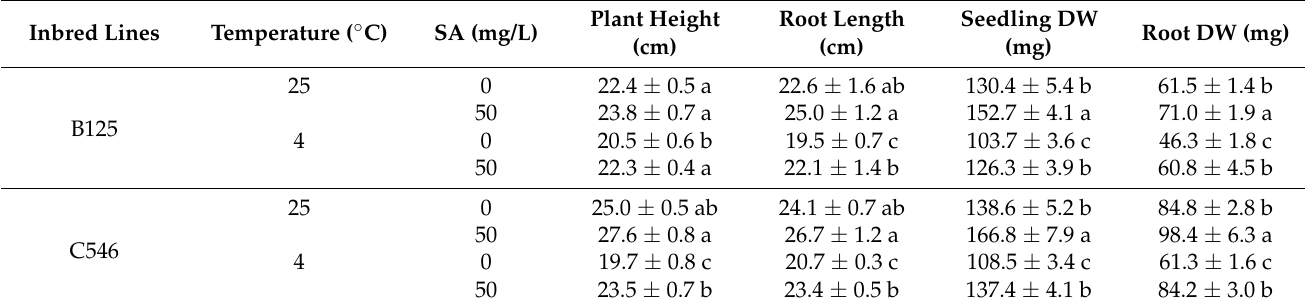
DW—dry weight. The values show the mean ± SE. The values marked with different letters indicate significant differences between different SA concentrations within the same inbred line in each column at p <